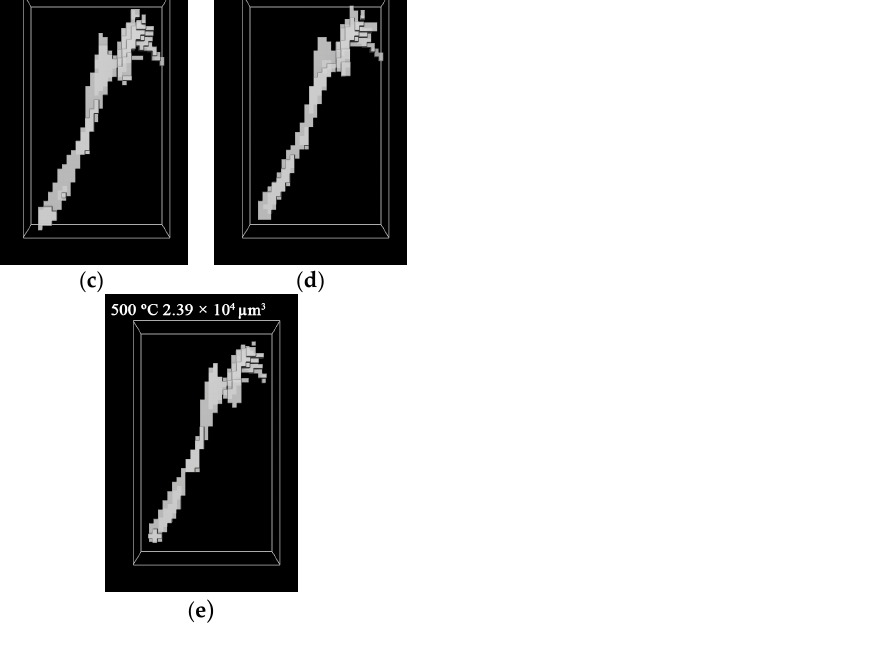
Figure 7. The 3D images of the size change of a long strip (Type Ⅱ ) pore with the temperature. ( a )